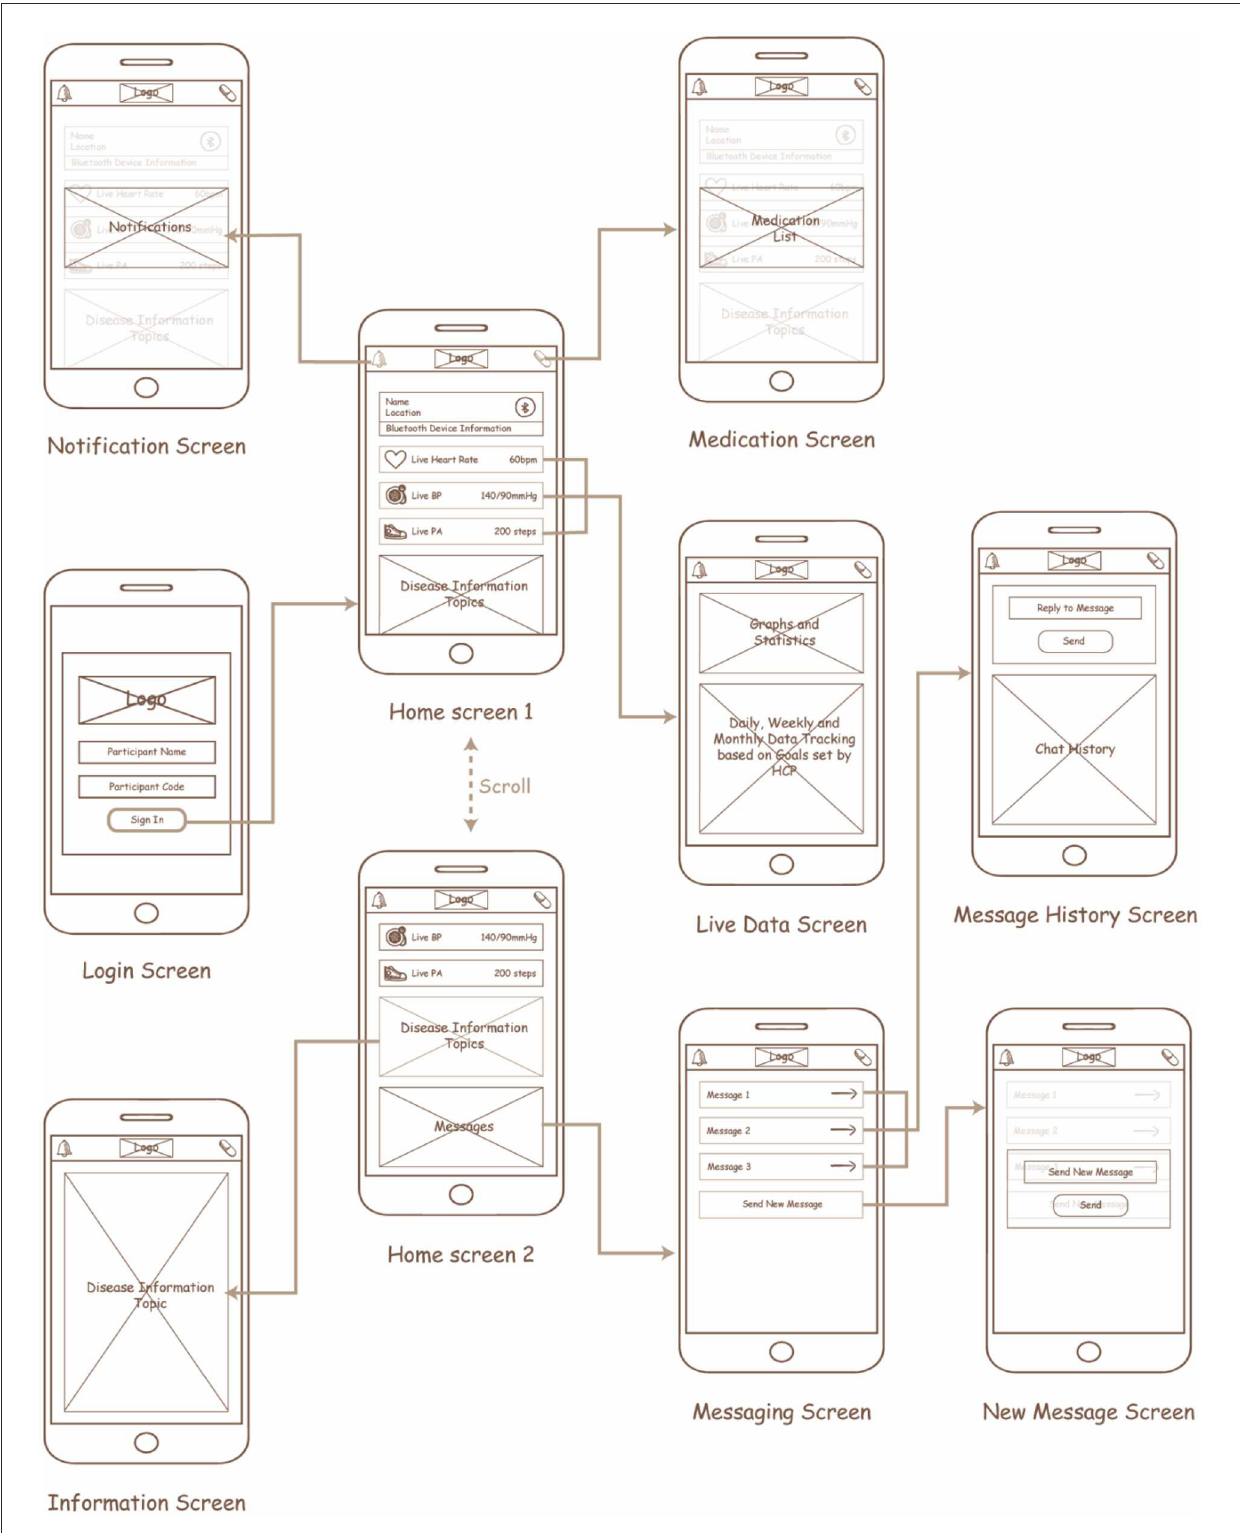
FIGURE5 Wireframe designs for the hypertension self-management app.